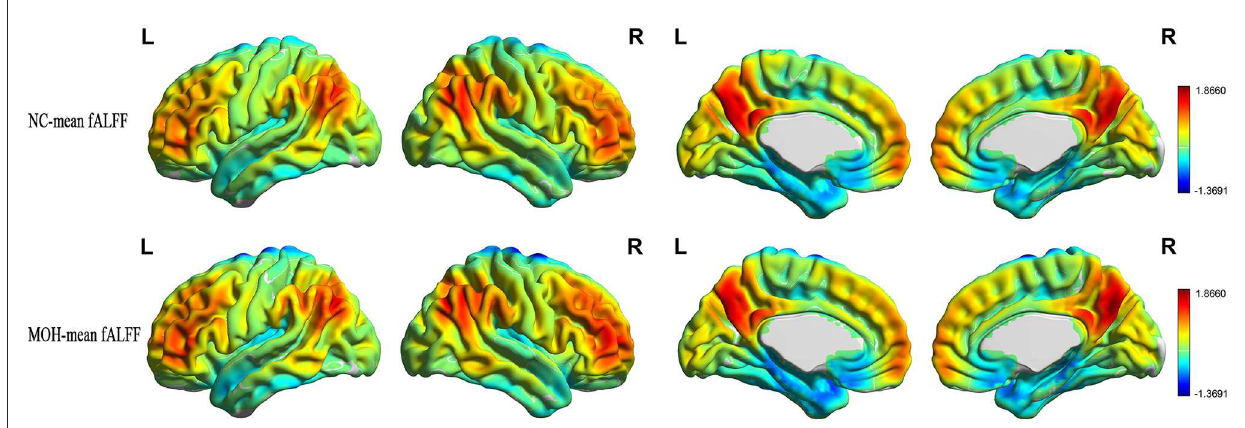
FIGURE6 Mean fALFF in normal controls (NCs) and patients with medication-overuse headache (MOH).